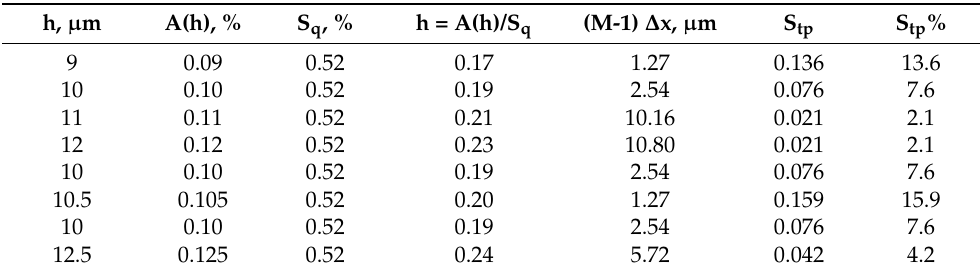
Table 3. The results of calculating the bearing capacity of the laser-alloyed surface of AISI 420 steel after wear testing.